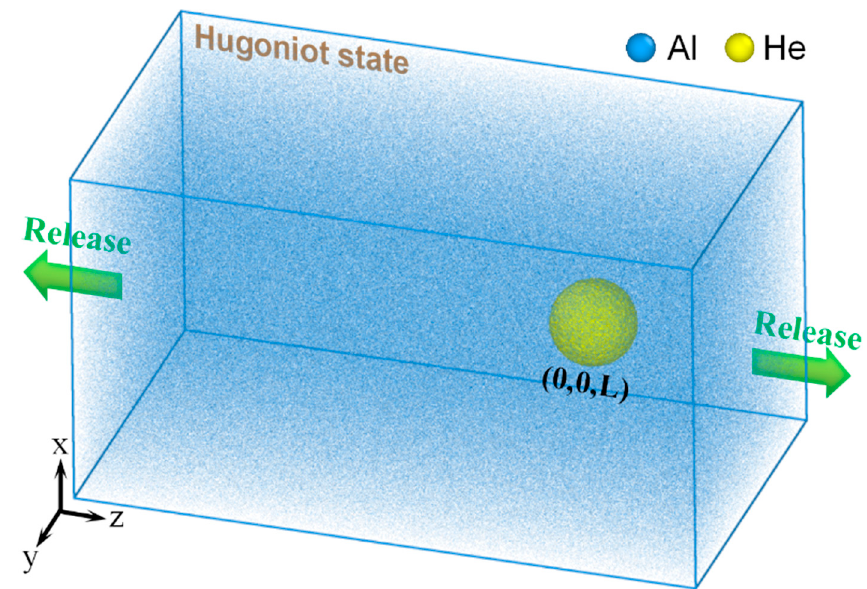
Figure 1. Three-dimensional view of Al–He system. A nanoscale He bubble of d = 10 nm is created inside the matrix. Three different positions along the z -axis from the center of the simulation cell, i.e., L = 0, 45 a and 76 a, are considered respectively.